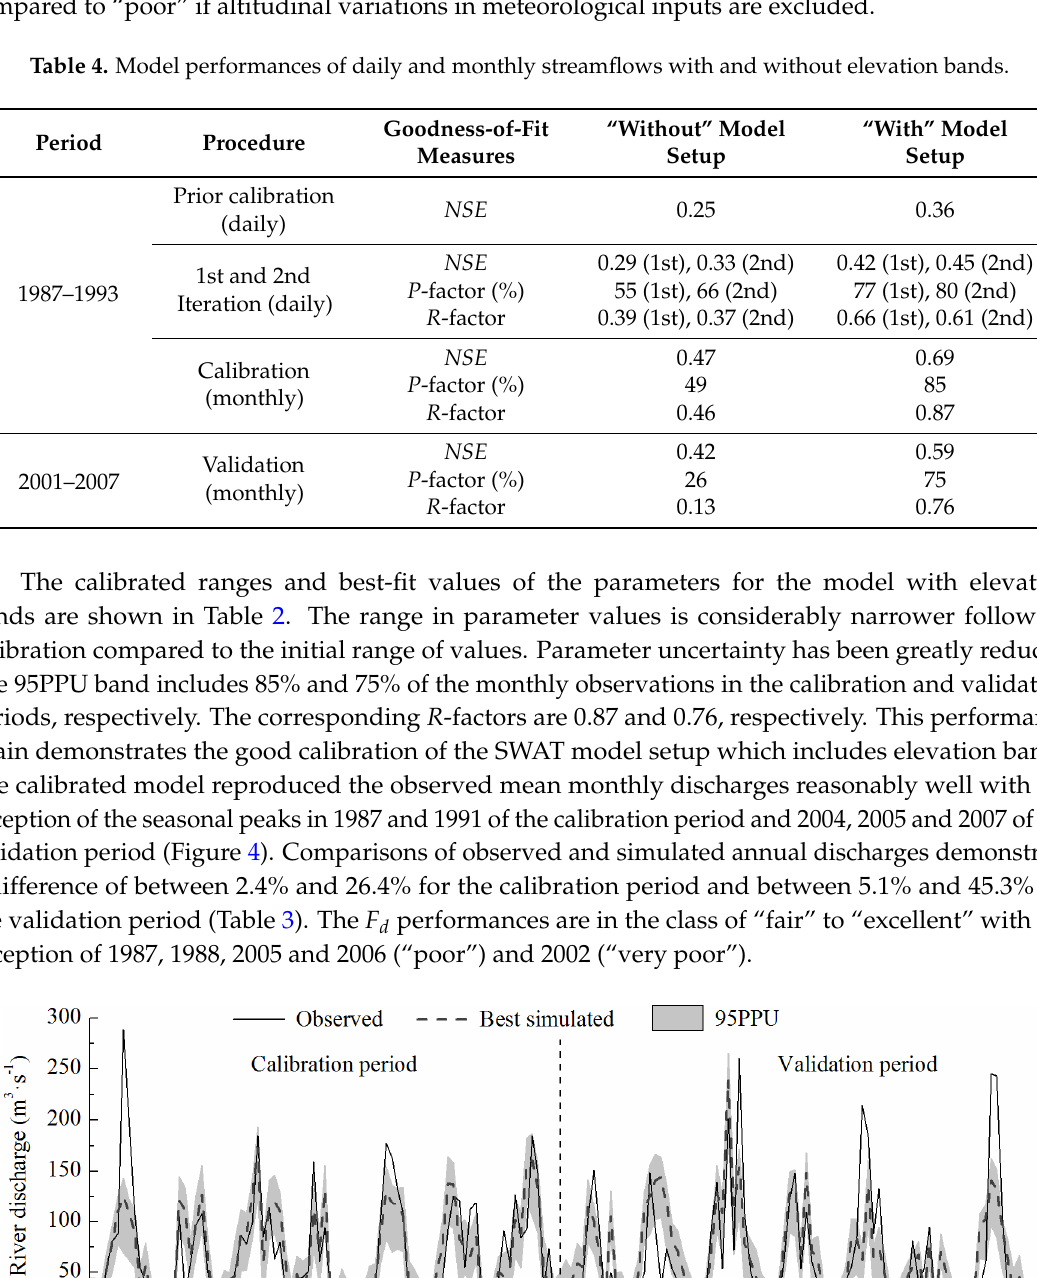
Figure 5. Observed and simulated (with and without elevation bands) river regimes for the Daning River at Wuxi over the period of calibration and validation. 4. Discussion Focusing efforts on sensitive parameters improves the efficiency of model calibration. The specification of precipitation and temperature lapse rates with elevation bands enables orographic effects upon precipitation (increases with altitude per km) and temperature (decreases with altitude per km), and in turn, evapotranspiration (declines with altitude) to be represented. This approach adjusts the potential underestimation of precipitation into the Daning catchment which results from the altitude of the meteorological stations at elevations which are not representative of the wider catchment while also correcting water removal by evapotranspiration and influencing simulated snow accumulation, sublimation and melting processes at higher altitudes. These two lapse rate parameters together with the other sensitive parameters (Table 2) determined the water allocation between infiltration or snow pack, surface runoff and evapotranspiration. The importance of CN2, Canmx, ESCO, Sol_AWC, Sol_K, and GWQMN parameters in the Daning SWAT hydrological model was also demonstrated by Shen et al. [36] who applied the one-factor-at-a-time parameter sensitivity analysis method. However, this earlier study did not differentiate the CN2 parameter of one land use from another while within the Daning model of the current study the CN2 parameter was distributed according to land over. They also did not consider snow-related processes, which are crucial to the hydrology of many mountain areas including the Daning catchment as confirmed by this study. This was the result of the exclusion of altitude dependent climate inputs. The time series of temperature they used was normally above zero and since temperature did not change with altitude there was never any snow simulated by their model. Employing elevation bands to vary precipitation and temperature with altitude led to large improvements in the simulation of river discharge, with NSE increasing by 0.22 in 1987–1993 and